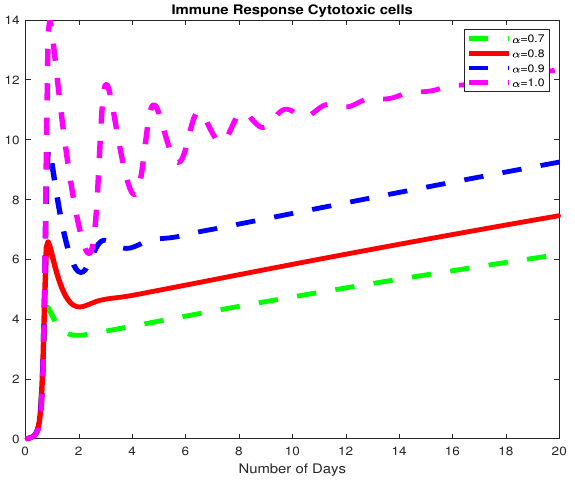
Figure 2. The dynamics of the Infected hepatocytes, I , for varying fractional order α .